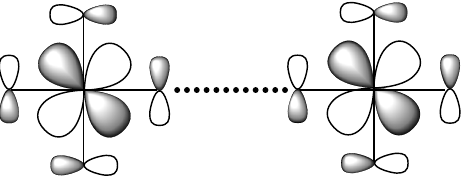
Figure 14. Interaction between two adjacent t 2g -states in Ba 2 NaOsO 6 .